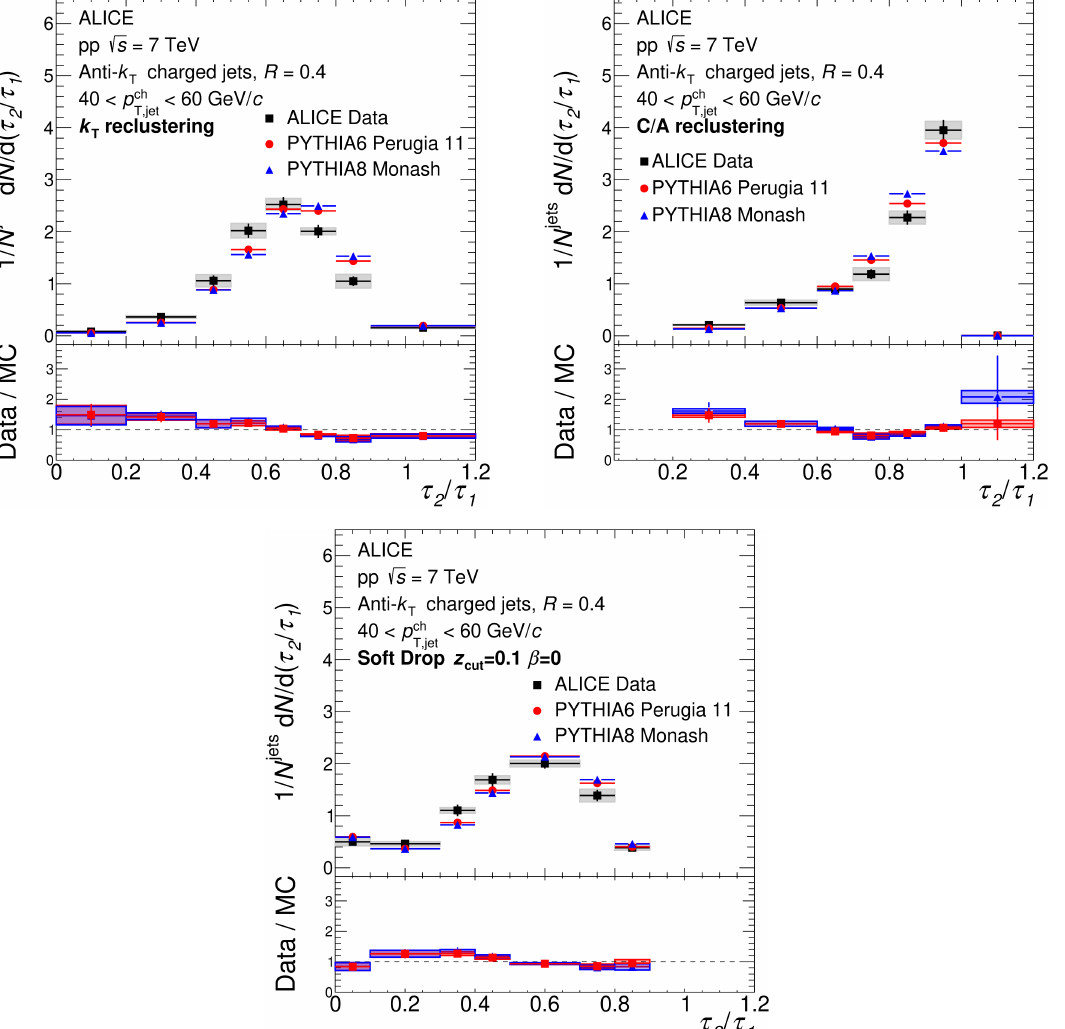
Figure 6 . Fully corrected τ 2 /τ 1 distributions, measured with the k T , C/A and C/A with Soft Drop √ grooming algorithms, in pp collisions at interval s = 7 TeV for jets with R = 0 . 4 in the jet p ch T , jet of 40 – 60 GeV /c , are shown. The systematic uncertainties are given by the grey boxes. The results are compared with PYTHIA6 Perugia 2011 and PYTHIA8 Monash. The uncertainties presented for the PYTHIA distributions are purely